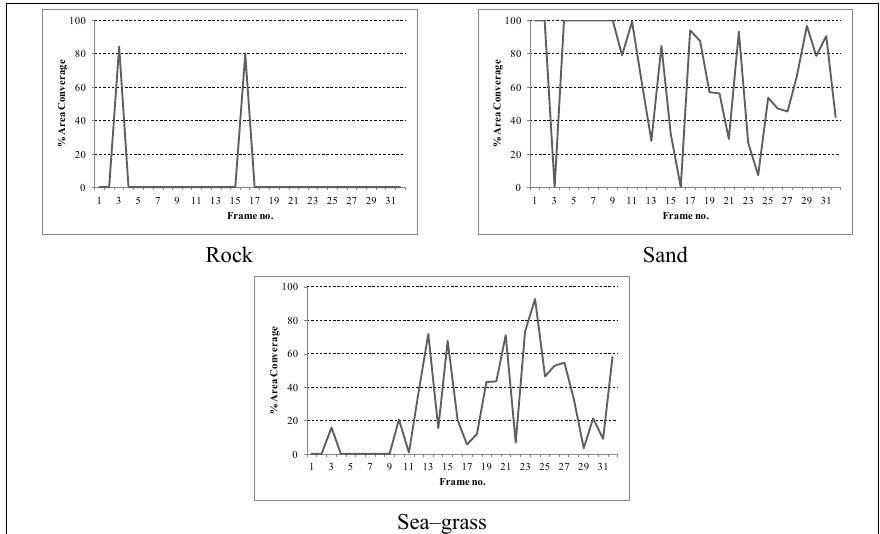
Fig. 9. Habitat map of Region